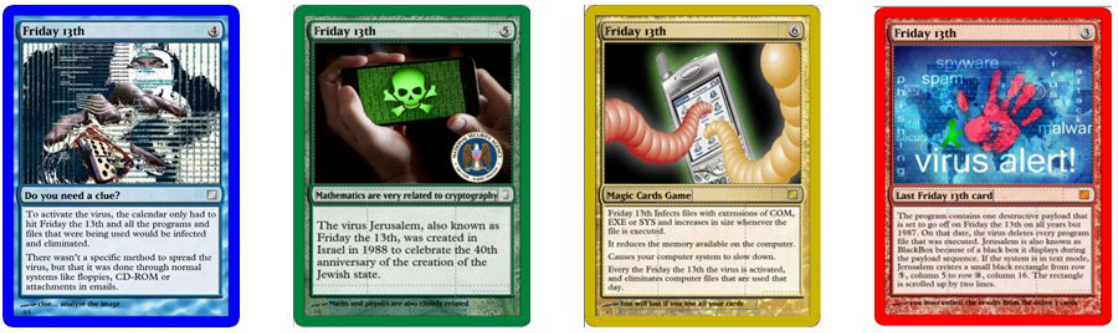
Figure 4. Magic cards with Friday 13th